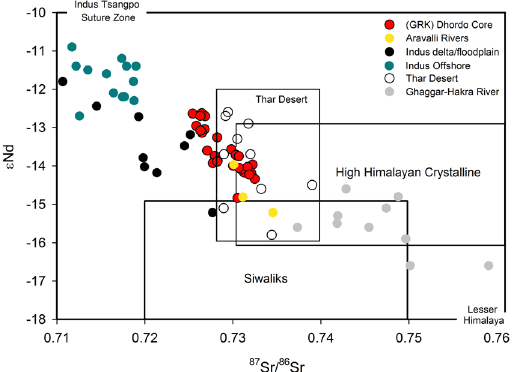
Figure 2. Scatter plot of 87 Sr/ 86 Sr and ε Nd isotope compositions of our GRK sediments, Indus delta/floodplain (Clift et al . 18, 22 ), Aravalli rivers (present study), Thar Desert (Tripathi et al . 25 ), Ghaggar-Hakra fluvial system (East et al . 23 ; Singh et al . 33 ; Alizai et al . 50 and the Indus shelf northwest of the Indus Canyon (Limmer et al . 19 ) along with various potential end-members such as High Himalayan Crystalline, Lesser Himalaya and Siwaliks (Singh et al . 17 ; Tripathi et al . 24, 25 and references therein). Graph was prepared using a licensed copy of Sigma Plot v.10.